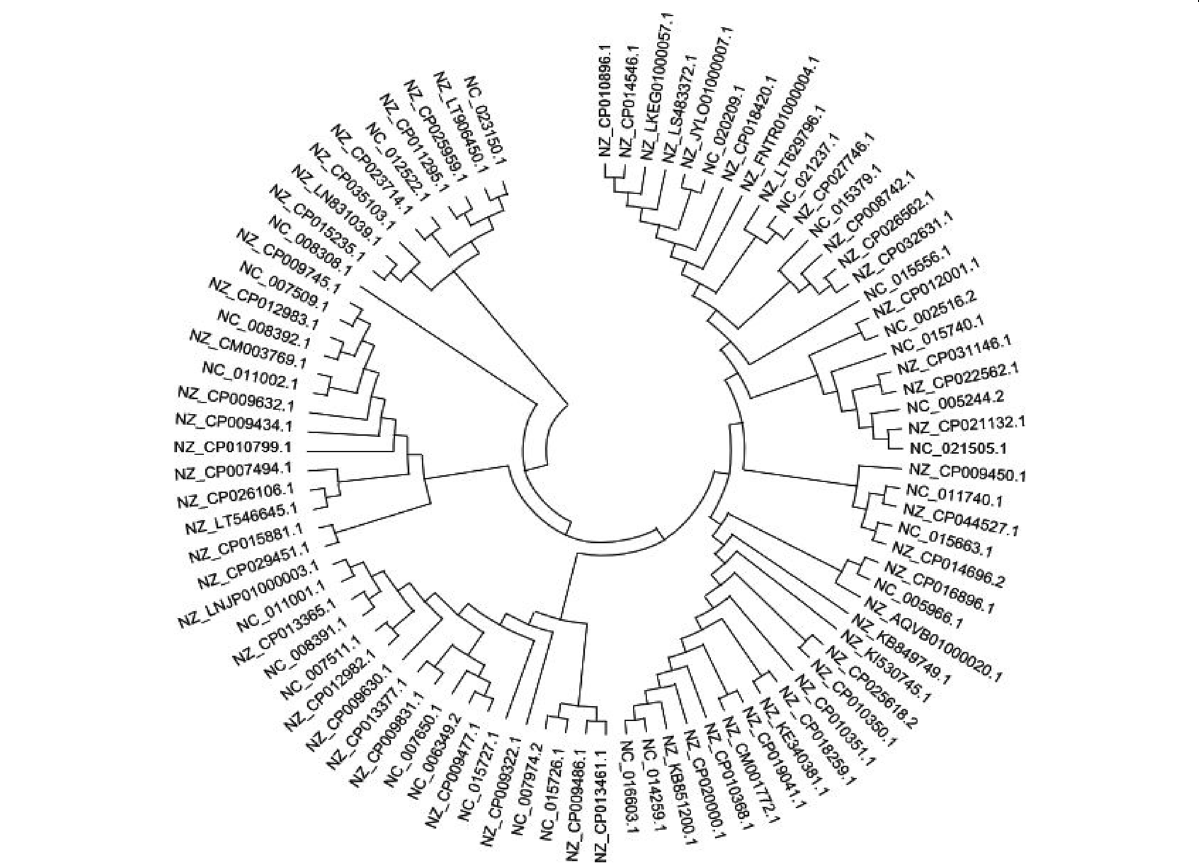
Fig. 1 Phylogenetic tree showing the relationship among catA sequences obtained from NCBI. The tree was constructed by neighbor-joining method. Genebank accession numbers are given at the terminal of the tree (leaf)